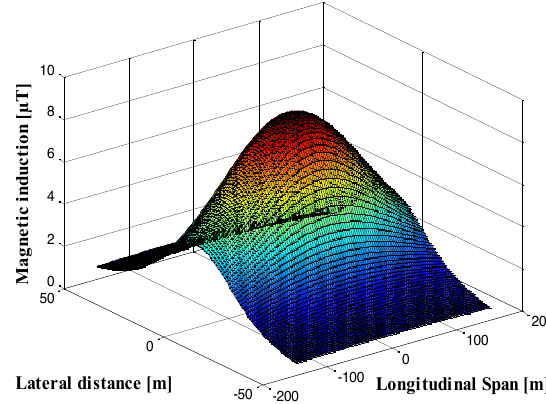
Figure 14: Three-dimensional (3-D) magnetic induction profile at 1 m above ground level.